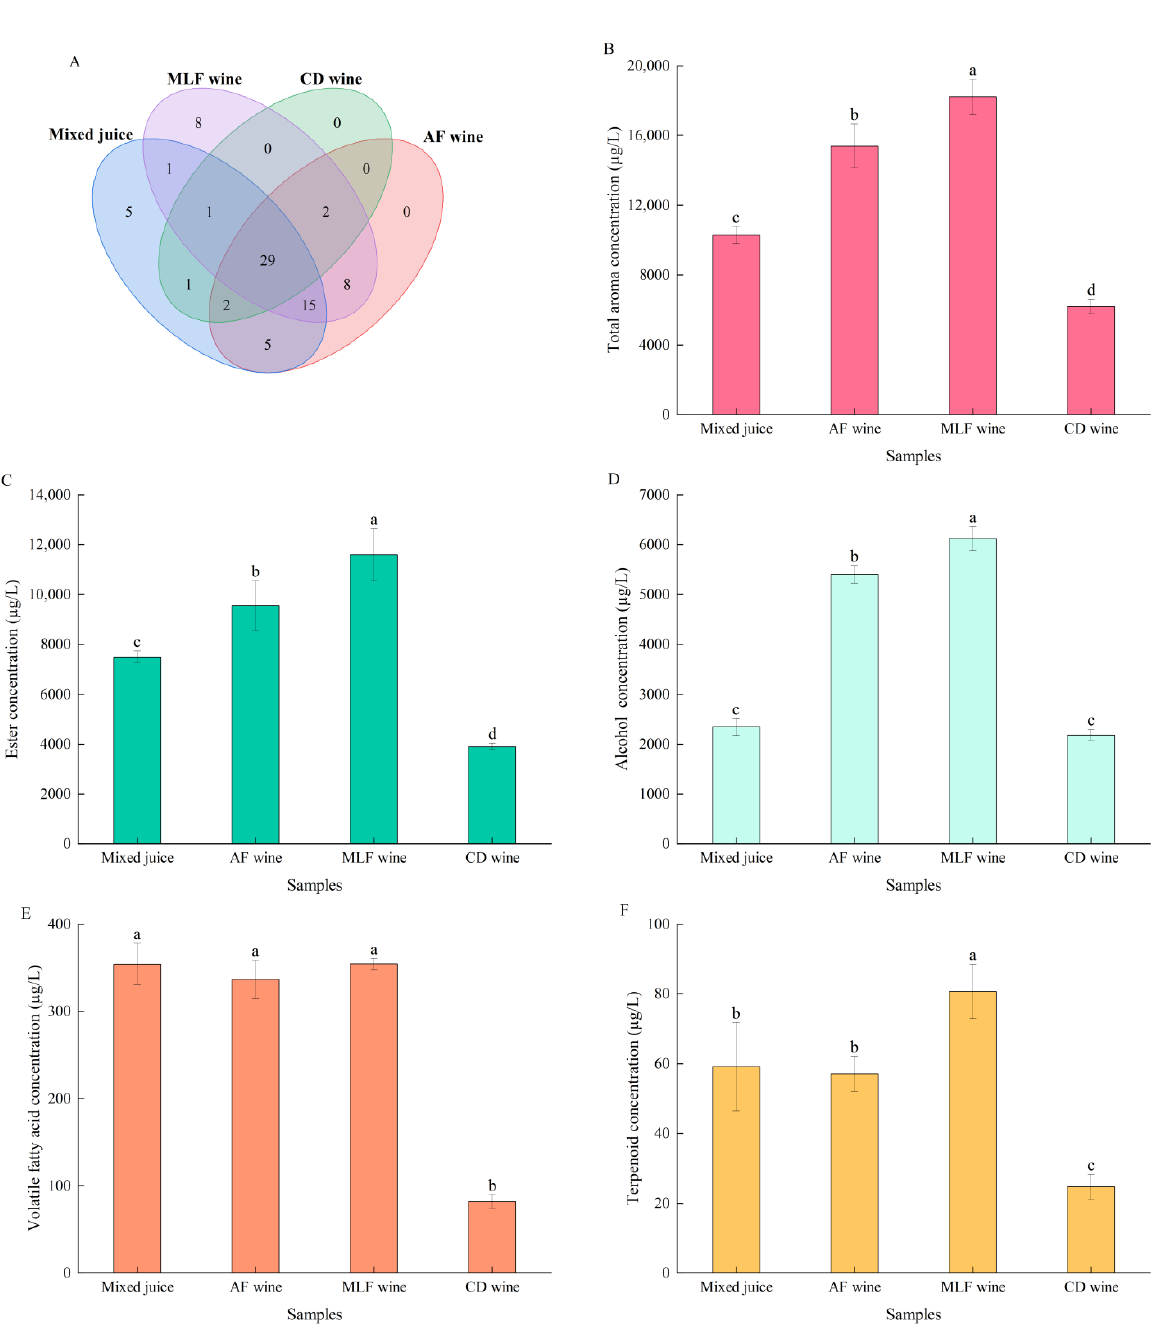
Figure 4. Effects of deacidification treatment on aromatic profile of pear–kiwifruit wine: ( A ) commonly and uniquely aroma compounds in pear–kiwifruit juice and corresponding wines with and without deacidification treatment; ( B ) total concentration of aroma compounds; ( C ) esters; ( D ) alcohols; ( E ) volatile fatty acids; ( F ) terpenoids. Error bars indicate the SD ( n = 3). Values with different letters are significantly different ( p < 0.05) among the samples.